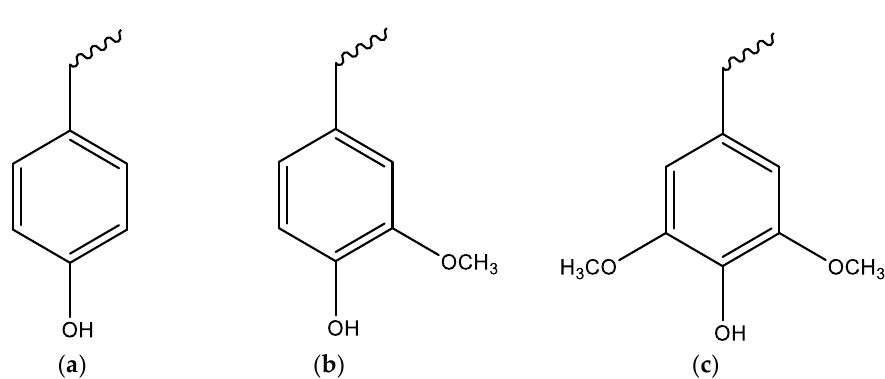
Figure 3. Monomeric phenols from the pyrolysis of lignin. ( a ) p -Hydroxyphenyl (H); ( b ) Guaiacyl (G); and ( c ) Syringyl (S) (adapted from [29]).